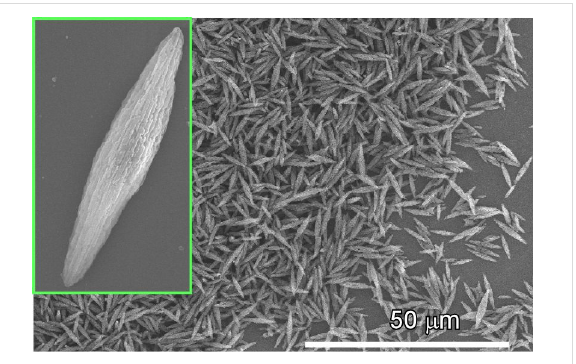
Figure 17: Nanoporous bitter-melon-shaped C 60 crystals with face- centered cubic lattice fabricated through liquid-liquid interfacial precipi- tation methods between isopropyl alcohol and C 60 solution in dodecyl-